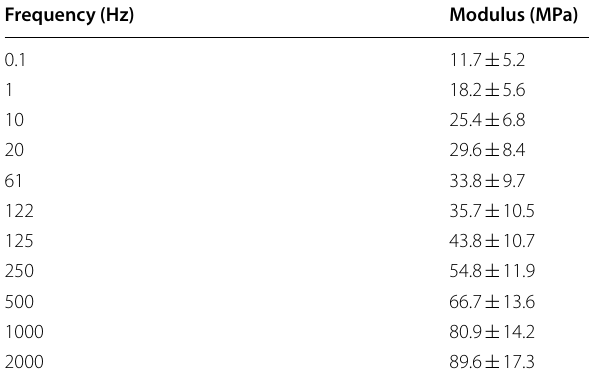
Table 1 Measured Young’s modulus at different frequencies